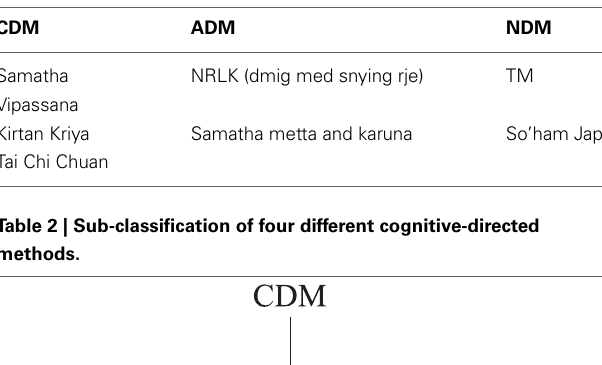
Table 1 | Examples of the sub-classification of the three domains.